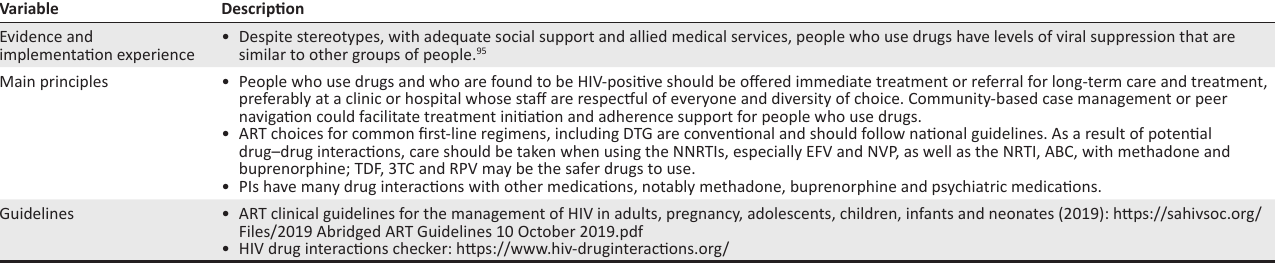
TABLE 19: HIV testing treatment and care – antiretroviral therapy.